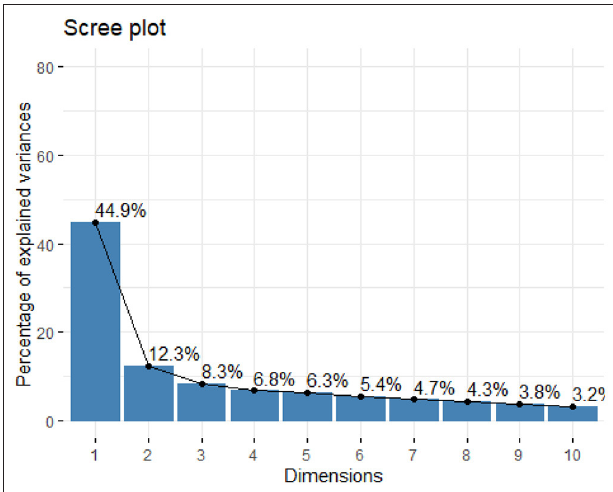
FIGURE 2 | Graphic of uni-dimensionality test. CONFEADO study, France, 2020.